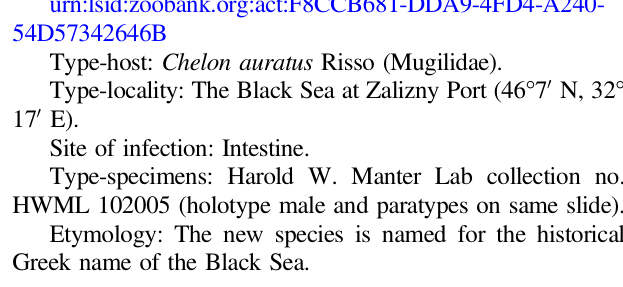
* Weight percent (WT%) is based on a total of 100. C, O, N are common elements of the protoplasm. Pd (palladium), Au (gold) and Ga (gallium) are omitted from the